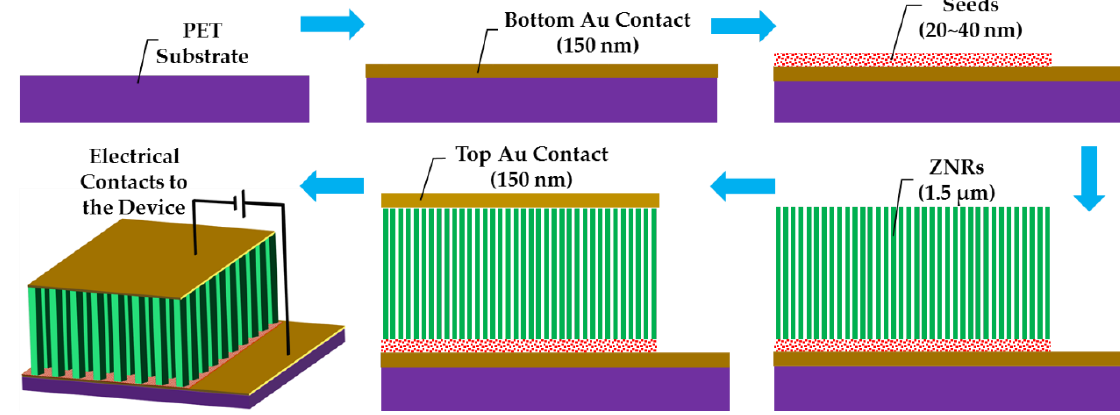
Figure 1. Step-by-step schematic representation of the device fabrication.